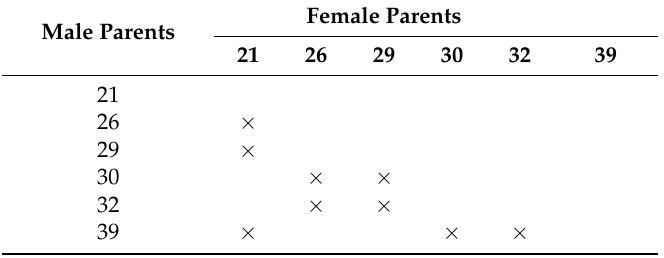
Table 1. Mating design for the nine longleaf pine families included in our